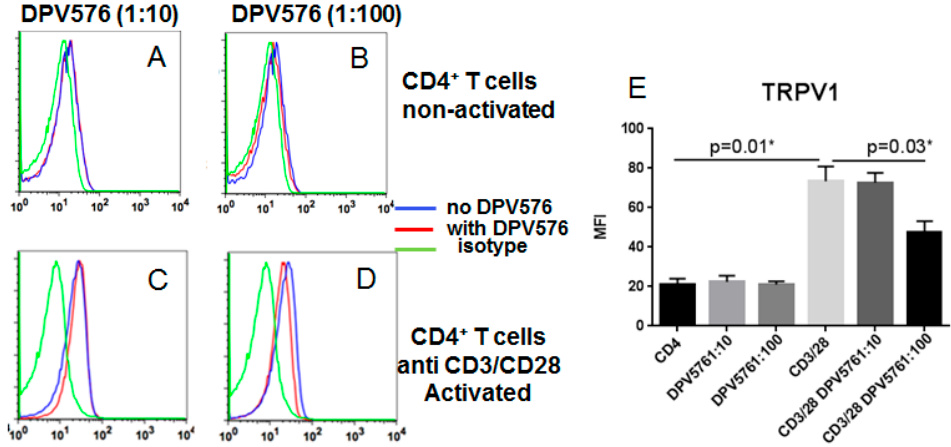
Figure 1. ( A – E ) DPV576 down modulates the expression of TRPV1 on activated CD4 + T cells. Non-activated- and anti-CD3/CD28-activated CD4 + T lymphocytes were exposed to DPV576 for 24h. The cells were stained for transient receptor potential vanilloid (TRPV) channels. Expression of TRPV1 on non-activated T cells ( A , B ). Anti-CD3/CD28 activated T cells with DPV576 ( C , D ). Data is representative of three such experiments. Blue: Without DPV576; Red: DPV576-exposed lymphocytes; Green: Isotype. Bar graph depicts the mean ± S.E. of MFI of the groups (E).